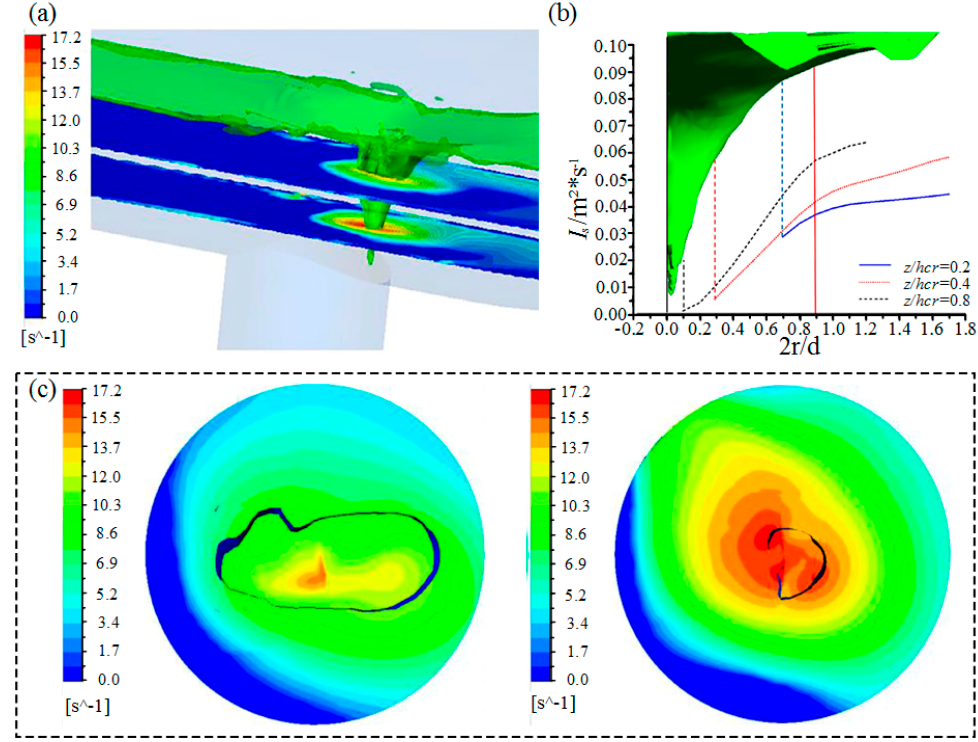
Figure 9. The dynamic evolution process of vortex intensity. ( a ) Swirling strength at different positions. ( b ) Vortex ‐ intensity ( I s ) curve. ( c ) Swirling ‐ strength contour. (Reprinted with permission from Ref. [81]. 2018, Springer Nature).